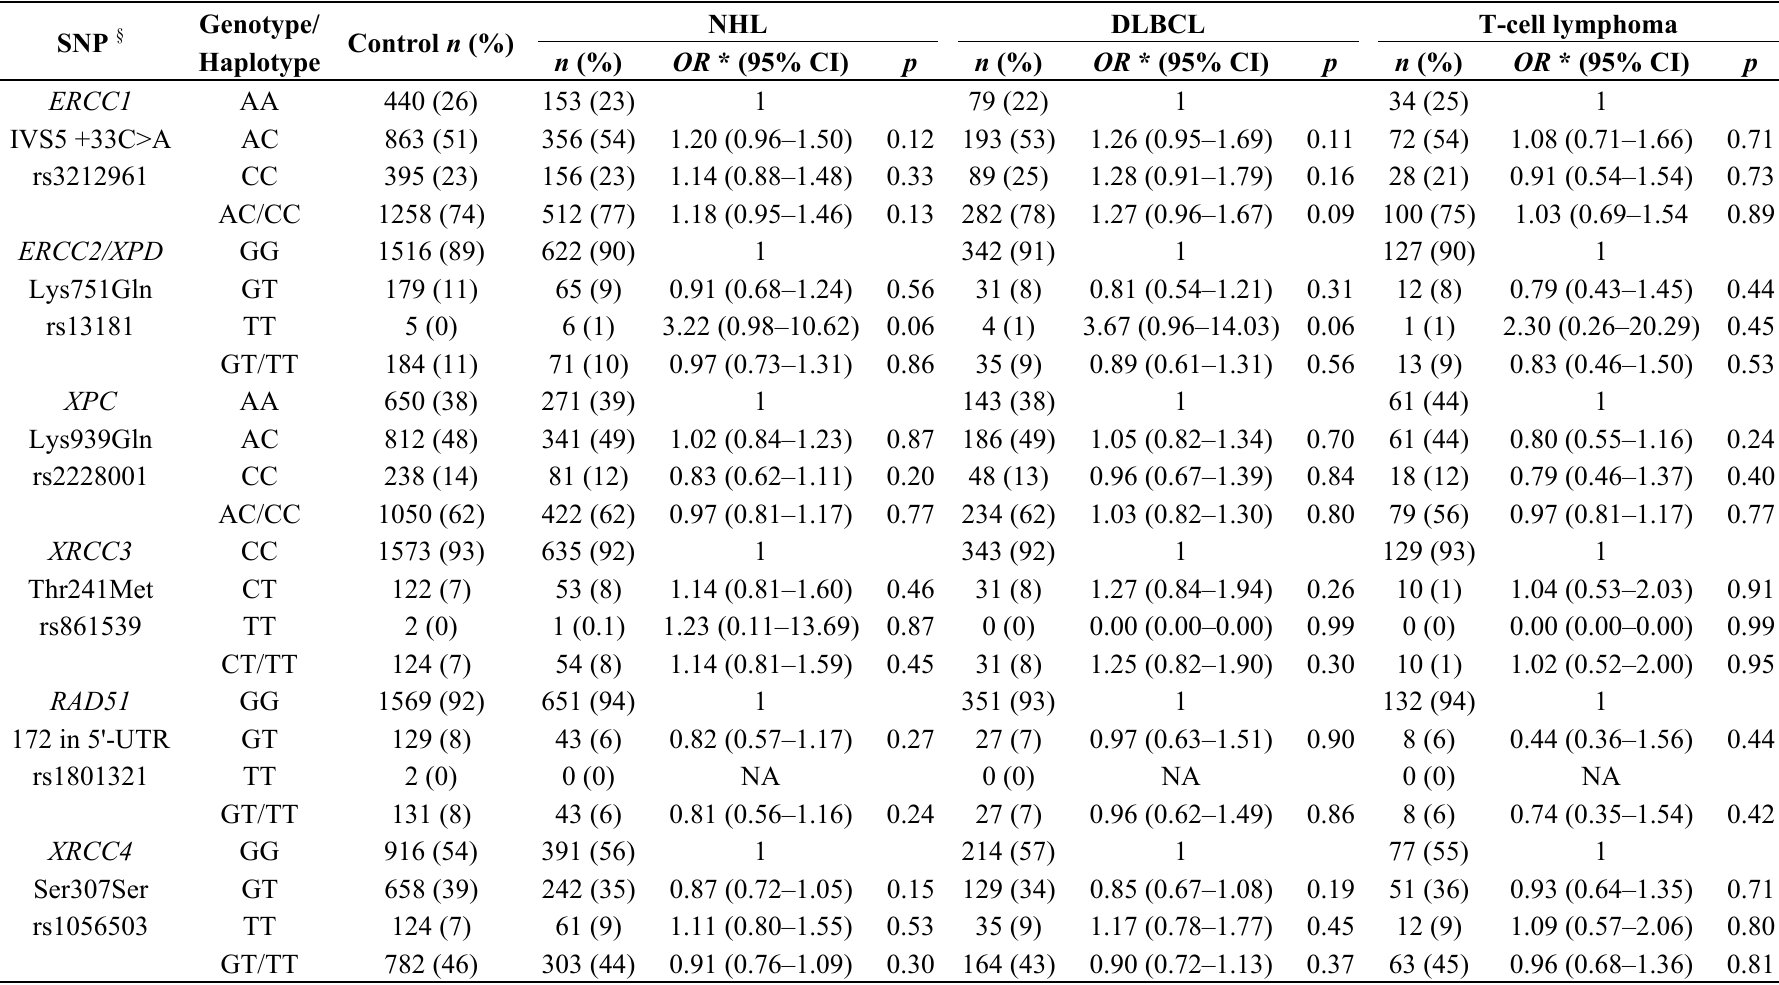
Table 2. Association between polymorphisms in DNA repair pathway and risk of non-Hodgkin lymphoma